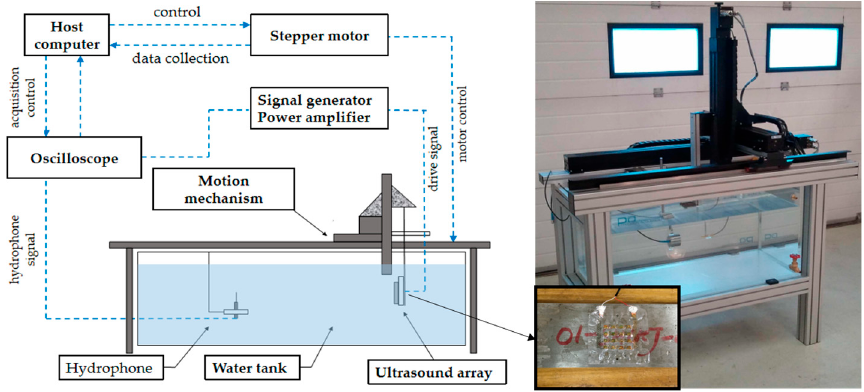
Figure 10. The schematic diagram of the test.